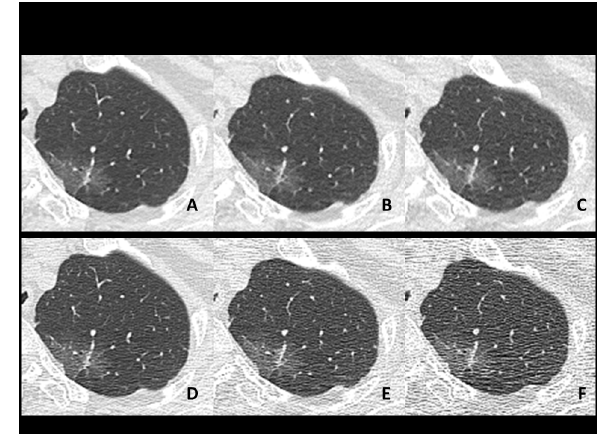
Figure 3. Axial plain chest CT images with a solid lung mass in the right middle lobe (75-year-old female weighing 56 kg). Images are arranged as in Figures 1 and 2. Spiculae were found on all images, while density heterogeneity inside the mass was severe on images at 60 mA without AIDR3D ( F ).